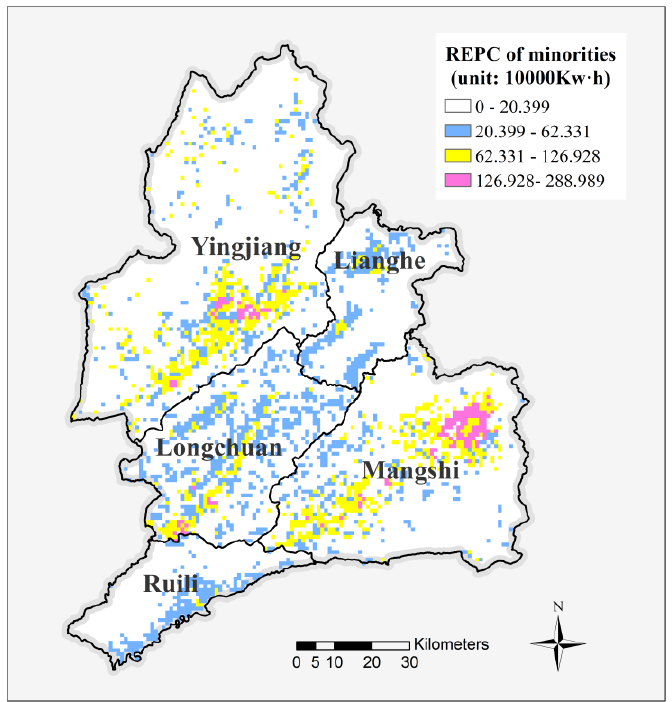
Figure 9. Rural electric power consumption (REPC) results of ethnic minorities.